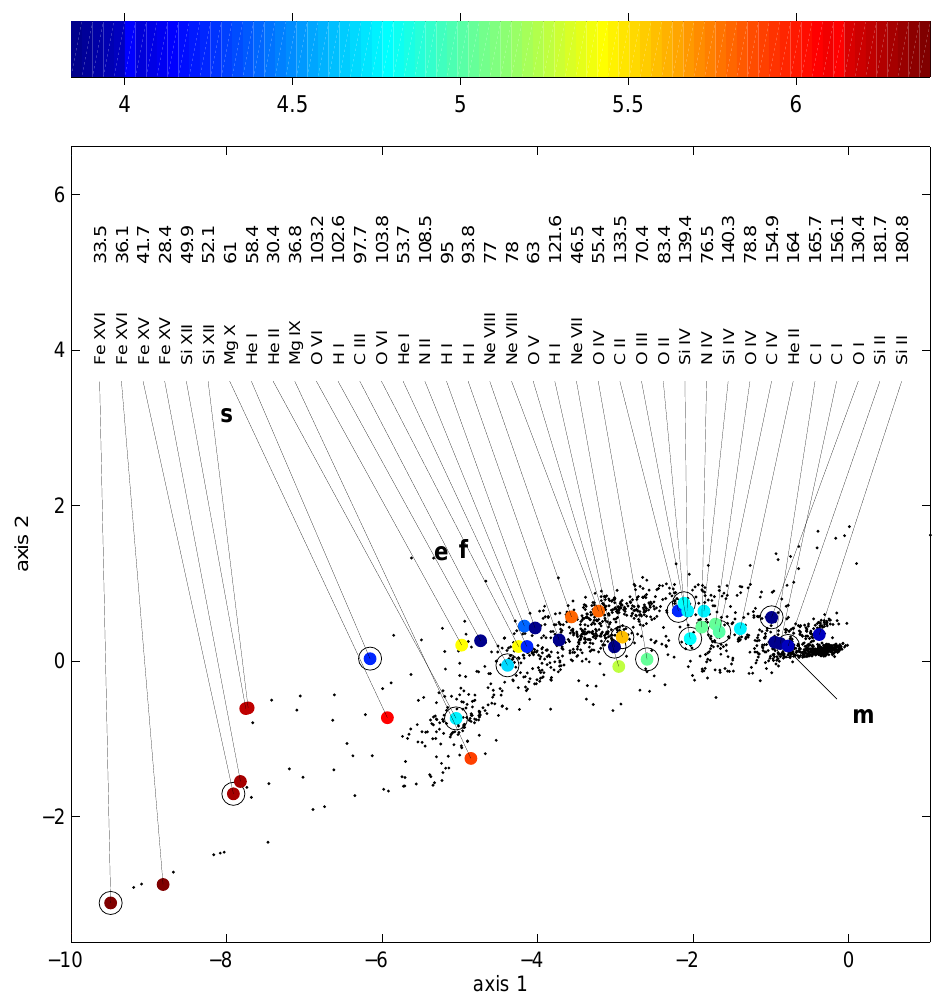
Fig. 5. Same 2-D representation as in Fig. 4, but only 38 strong lines are highlighted. The colour code refers to the decimal logarithm of the emission temperature [K]. Letters refer to various proxies: s (international sunspot number), f (F10.7 radio flux), m (MgII core-to-wing index) and e (E10.7 index). The 14 reference lines to be used later in this study are